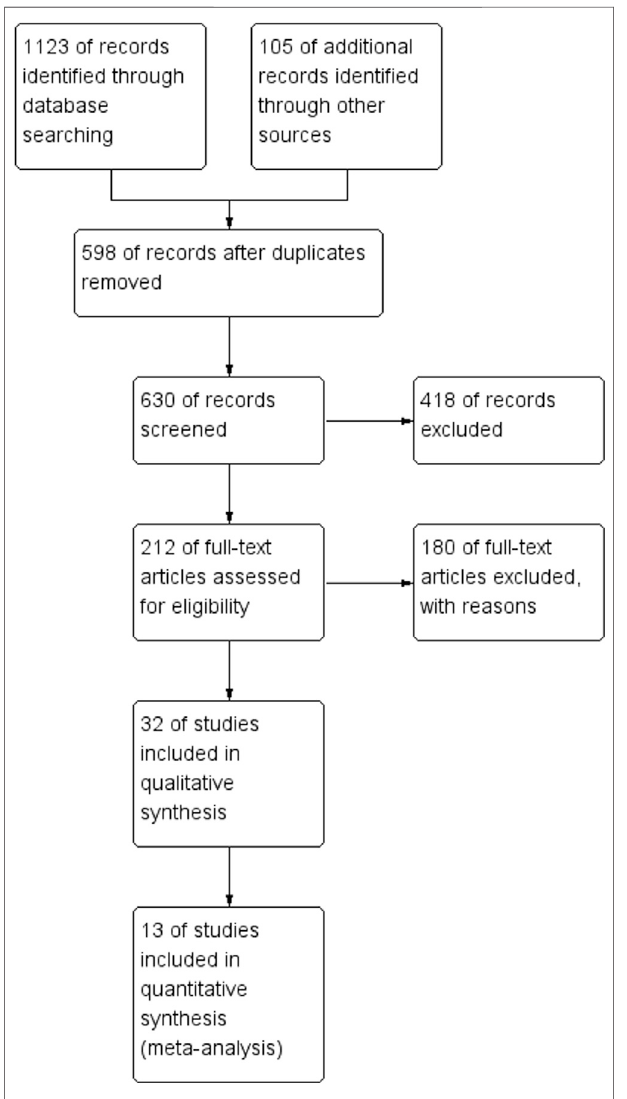
FIGURE 1 | Work fl ow showing literature extraction (details provided in Methods).